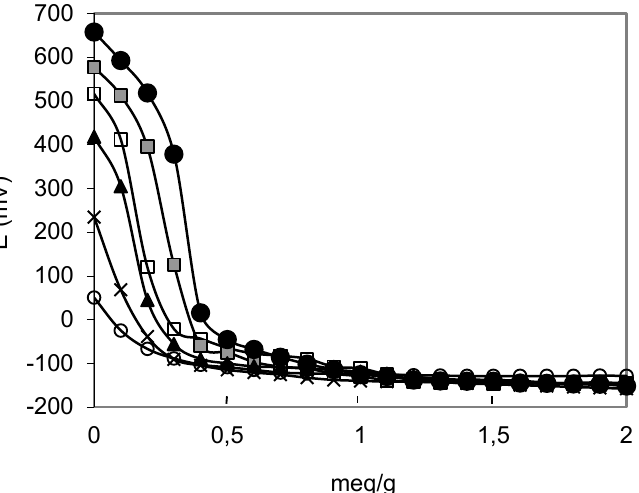
Figure 5. Potentiometric titration of the catalyst. ( ○ ) KIT-6; ( × ) PW1-K-6; ( ) PW2-K-6; (( ) PW3-K-6; ( ) PW4-K-6; ( ) PW5-K-6.